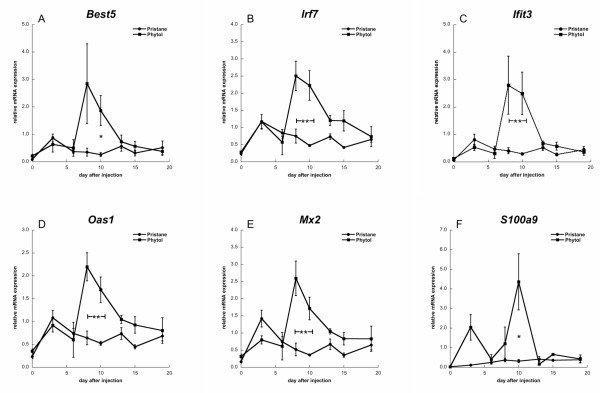
The relative mRNA expression of (A) Best5, (B) Irf7, (C) Ifit3, (D) Oas1, (E) Mx2 and (F) S100a9 in lymph nodes at 0, 3, 6, 8, 10, 13, 15 and 19 days after injection with pristane (circles) or phytol (squares). Values are means ± SEM from groups of four animals. Levels of significance were calculated using Student's t-test (*p < 0.05; **p < 0.01).